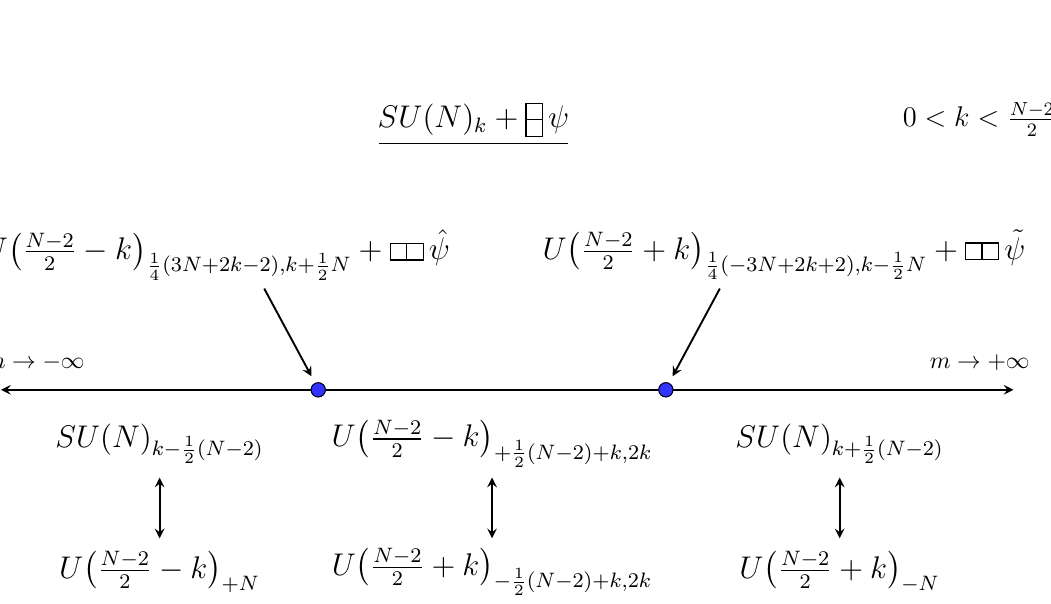
Figure 3 . Phase diagram of SU( N ) with a symmetric fermion for 0 < k < N +2 represent a phase transition between the asymptotic phases and the intermediate quantum phase. Each phase transition has a dual gauge theory description, which appears with an arrow pointing